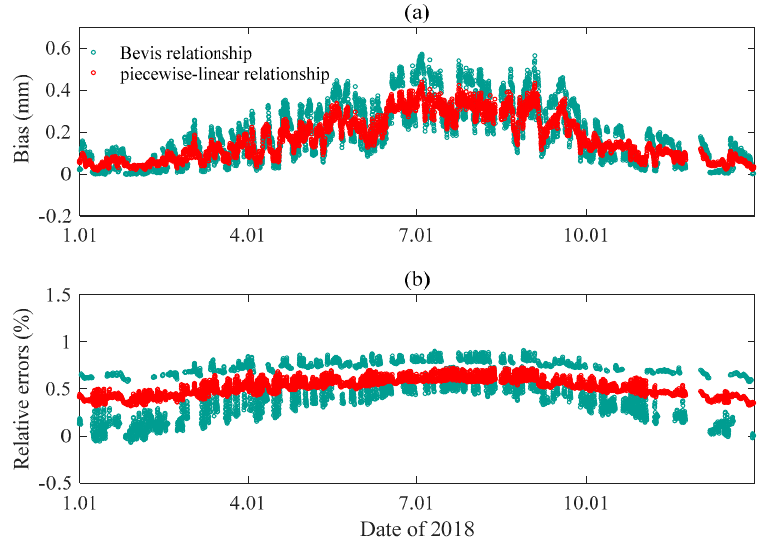
Figure 7. Bias (mm) ( a ) and relative error (%) ( b ) of the precipitable water vapor (PWV) calculated based on different T m - T s models at GXHC station in 2018. The blue dots are the PWV based on the Bevis model, and the red dots are the PWV based on the site-specific piecewise-linear model. The distribution of water vapor in the atmosphere is not uniform. Thus, the ground- based GPS water vapor can get the average distribution of water vapor in each satellite signal direction. In addition, the layered meteorological parameter data of the radiosonde is not strictly vertical. These factors will bring errors into the PWV results. However, it still can be seen that the accuracy of the PWV is significantly improved based on site-